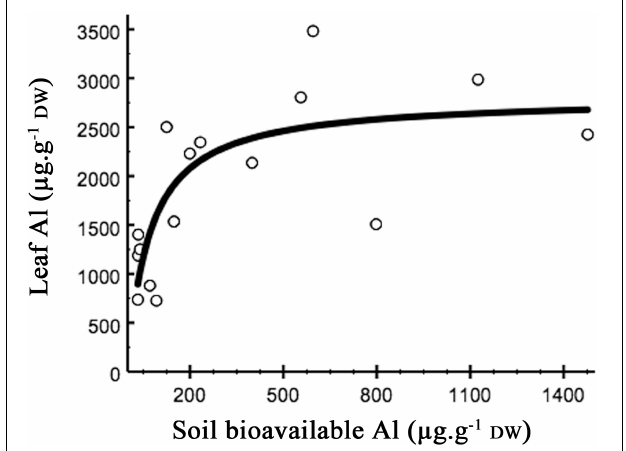
FIGURE 2 | Accumulation of Al in Plantago almogravensis leaves related to soil-bioavailable Al. Fitted model: y = (2,804 × x )/(69.7 + x ); R 2 = 0.576 (observed vs . fitted values). Data from Serrano et al. (2011); adapted from Serrano (2015), p. 153.